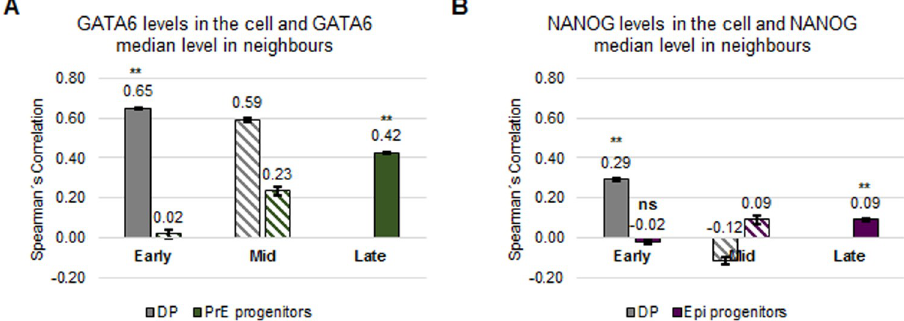
Fig 3. DP cells in early blastocysts cluster together according to their GATA6 levels (data I). (A-B) Spearman’s correlation coefficients of GATA6 levels of a cell and median GATA6 levels of its neighbours (A) or of NANOG levels of a cell and median NANOG levels of its neighbours (B) in the indicated populations in the ICM at the indicated embryonic developmental stages for data I. The error bars represent the standard errors calculated by bootstrap sampling the experimental data 100 times. �� : p < 0.01; Mann-Whitney test with Bonferroni correction for the null model; ns: not significant. See also S5 Fig and S1 Text for further details. Striped boxes indicate those populations composed of less than 108 cells. In those cases, no statistical analysis was performed. Details on the number of embryos and cells analysed are in S1 and S2